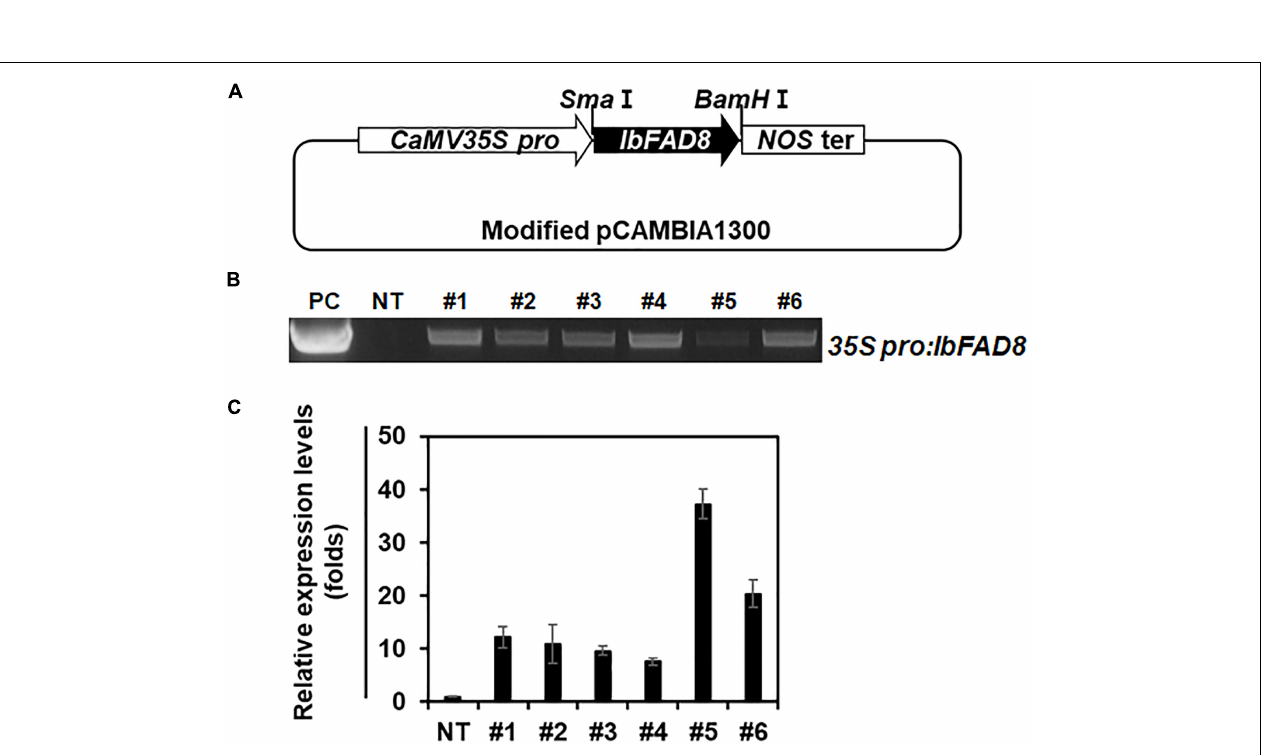
FIGURE 3 | Generation of transgenic sweetpotato plants overexpressing IbFAD8 . (A) Schematic diagram of the vector used to generate transgenic sweetpotato lines. The IbFAD8 gene was expressed under the control of the cauliflower mosaic virus 35S (CaMV35S) promoter. (B) Gel image showing the results of genomic DNA (gDNA) PCR. PC, positive control; NT, non-transgenic plants. (C) Expression levels of IbFAD8 in the leaves of transgenic lines. Lines #5 and #6 with high transcript levels (referred to as TF5 and TF6, respectively) were selected for further characterization.